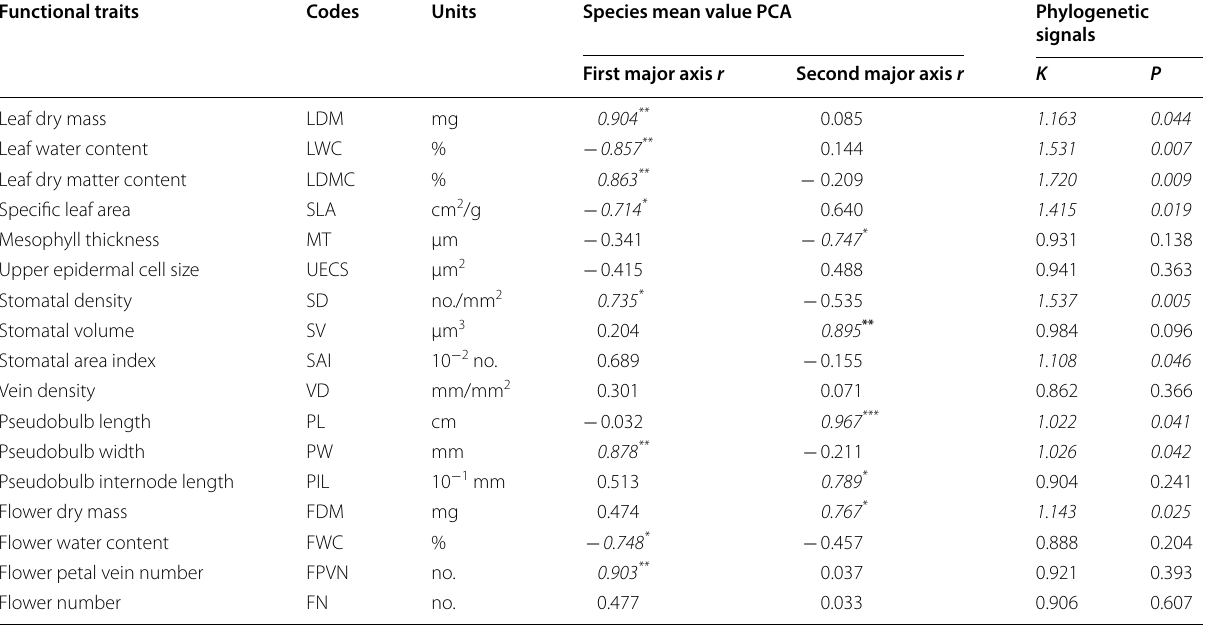
Table 1 Correlation coefficients ( r ) of the first two axes of PCA and phylogenetic signals ( K ) for the functional traits of Dendrobium species in this